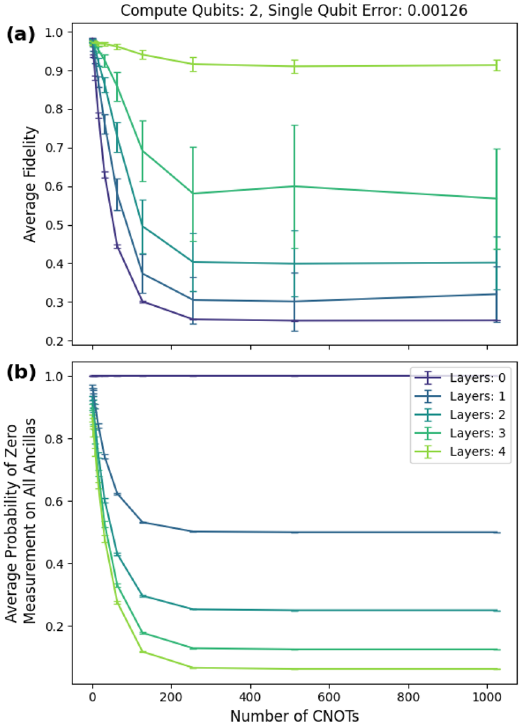
Figure 9. Two-qubit Clifford simulation with single-qubit error of 0.00126 (0.0126 two-qubit error). Note that while these input circuits can be optimized to use O ( n 2 / log ( n )) cnot gates (i.e., O(2) cnot gates), these simulations provide intuition that the protocol is suitable for deep circuits.